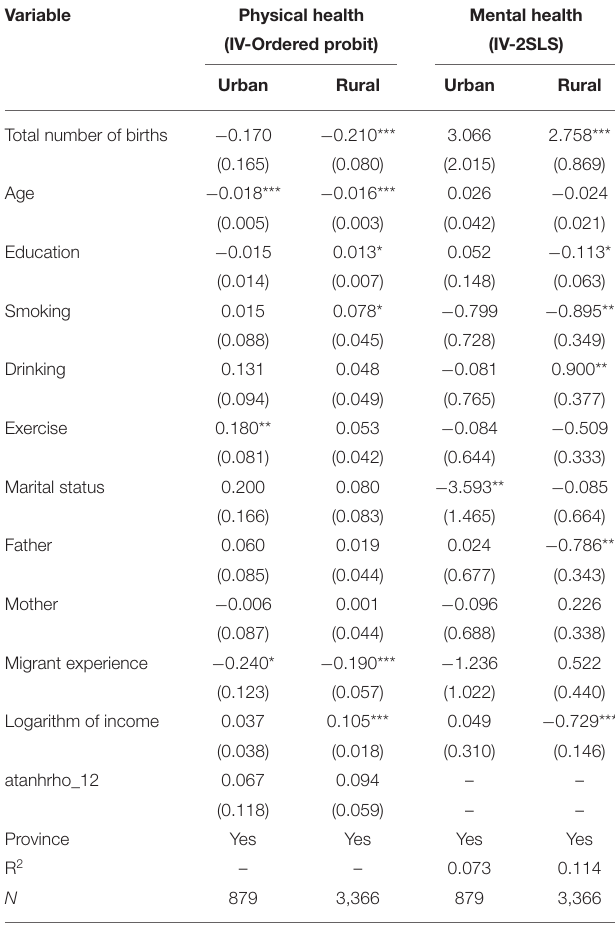
TABLE 5 | Heterogenous impacts of fertility on physical and mental health of women of childbearing ATE 95% CI Lower Upper